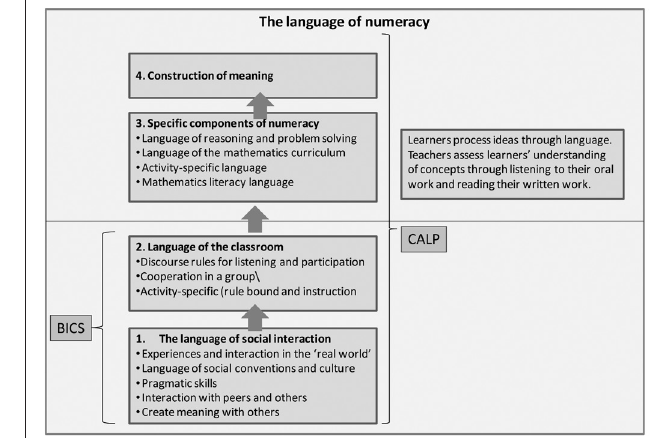
Fig. 1. The numeracy discourses used in classrooms (Gawned, 1993) (BICS = basic interactive communicative skills; CALP = cognitive academic language